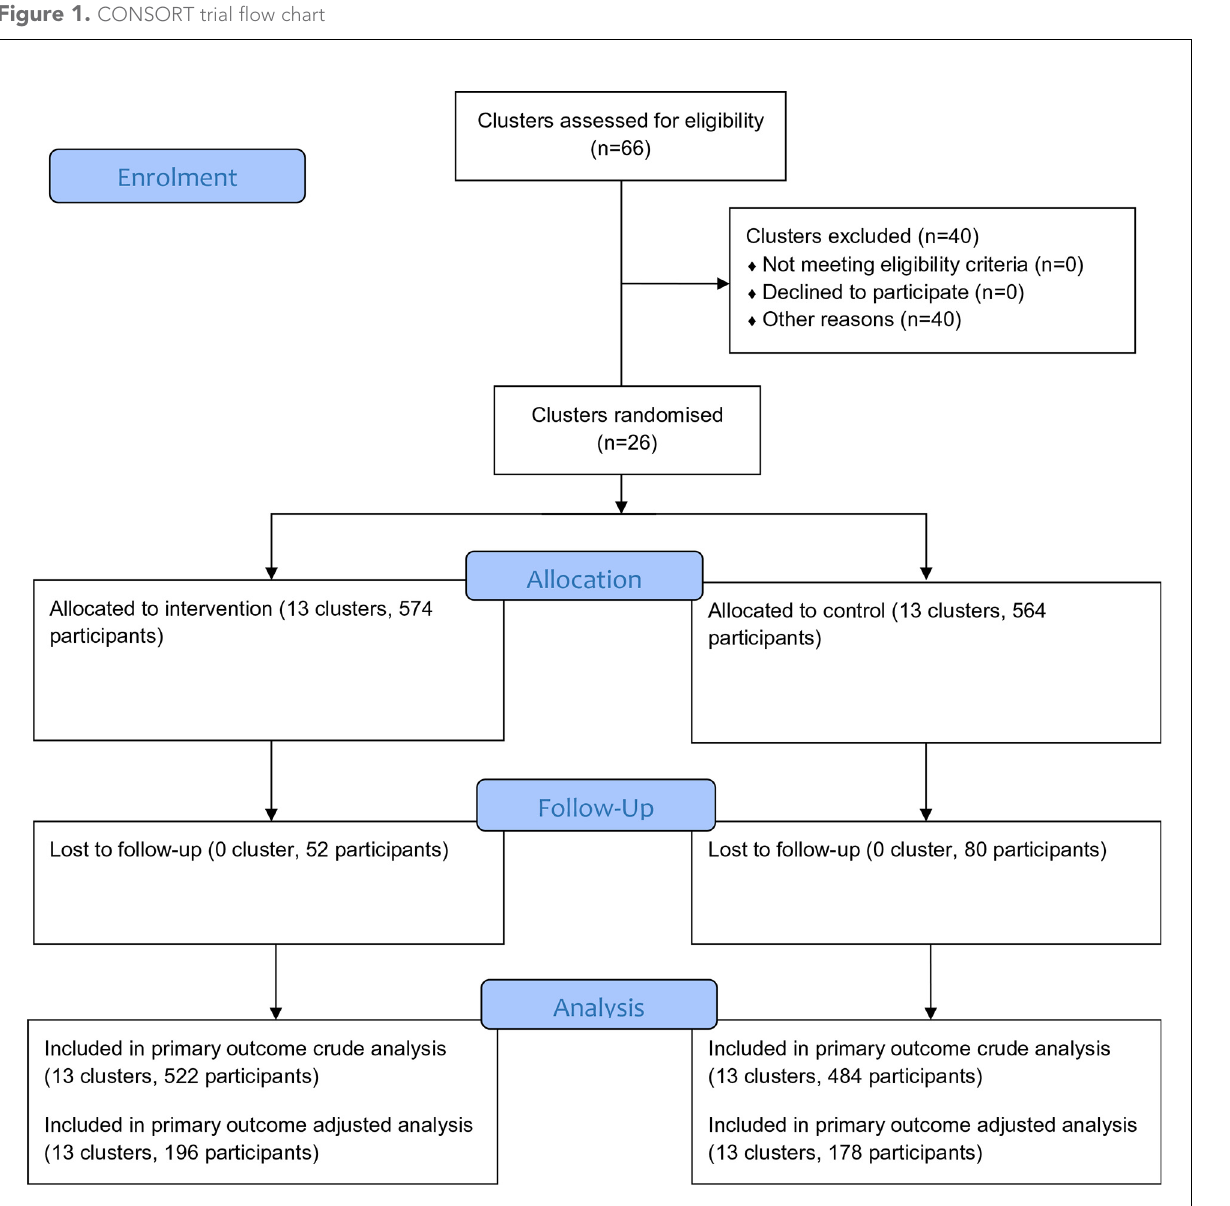
Figure 1. CONSORT trial flow